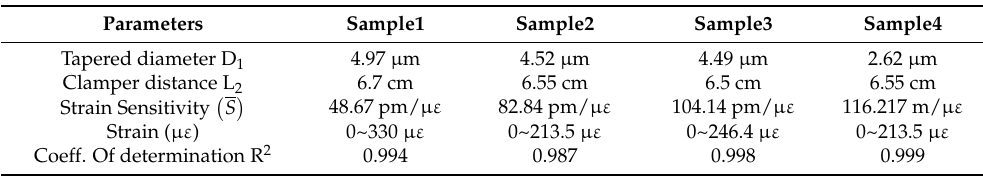
Table 1. Working parameters of the strain sensors.